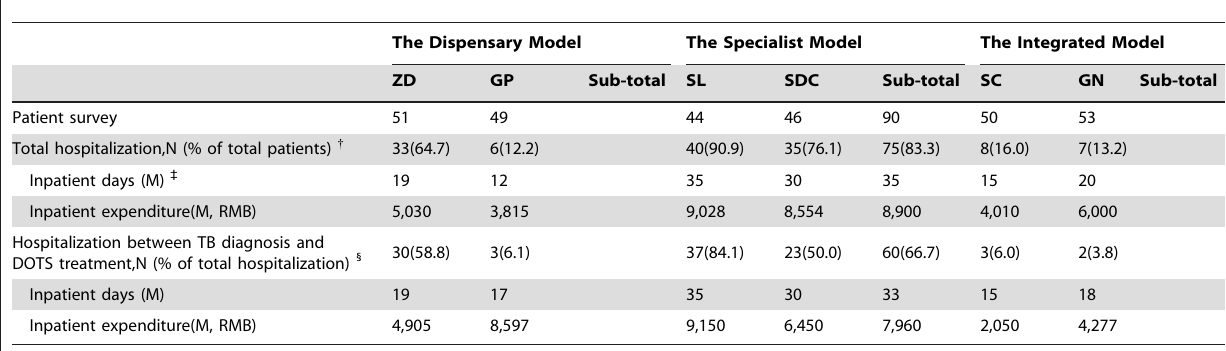
Table 5. Hospitalization of TB patients in the three models.